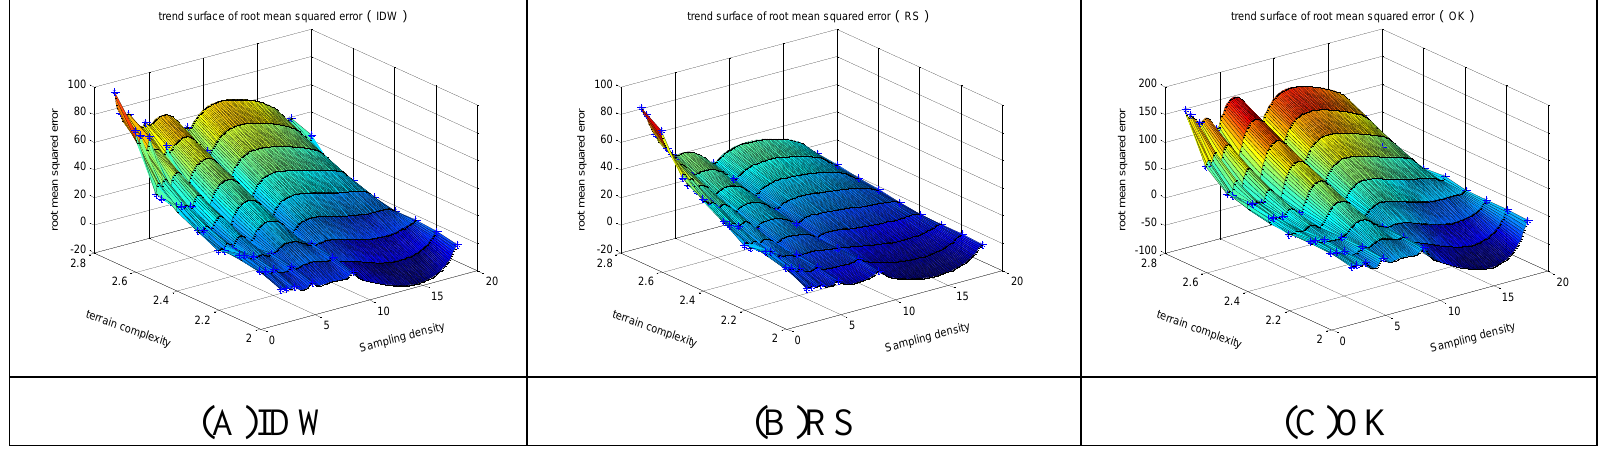
Figure 11. The RMSE s of the 3 methods in combined sampling. ( A ) The trend surface of RMSE s for IDW; ( B ) The trend surface of RMSE s for RS; ( C ) The trend surface of RMSE s for